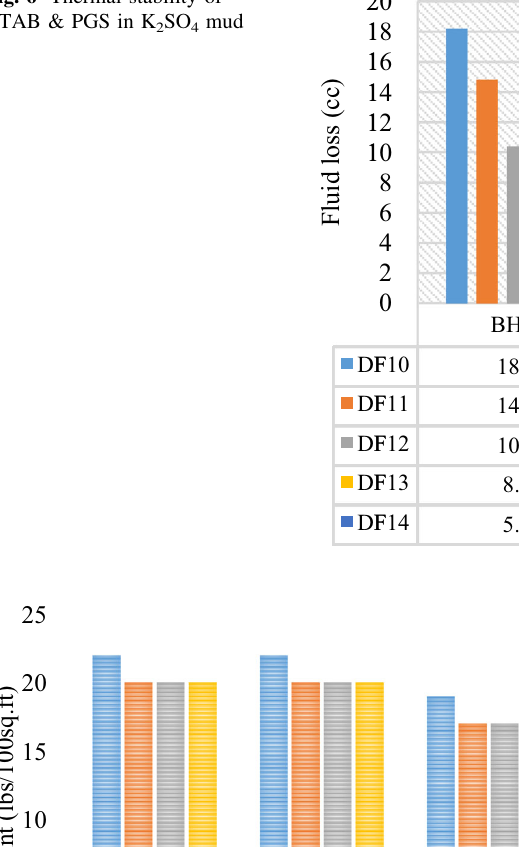
Fig. 6 Thermal stability of